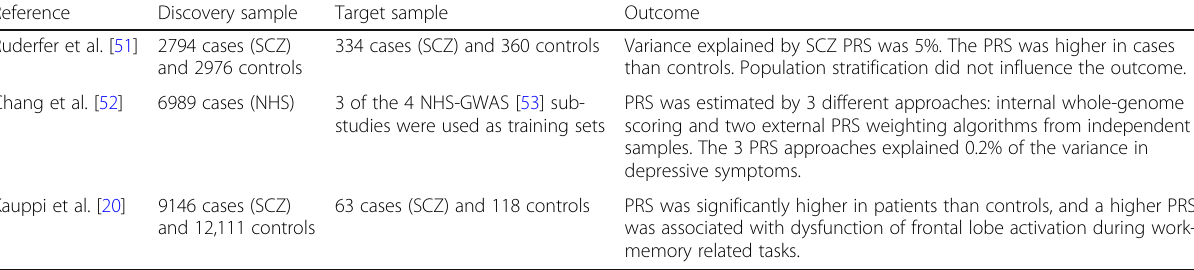
Table 1 Prediction of case control status using Polygenic Risk Score